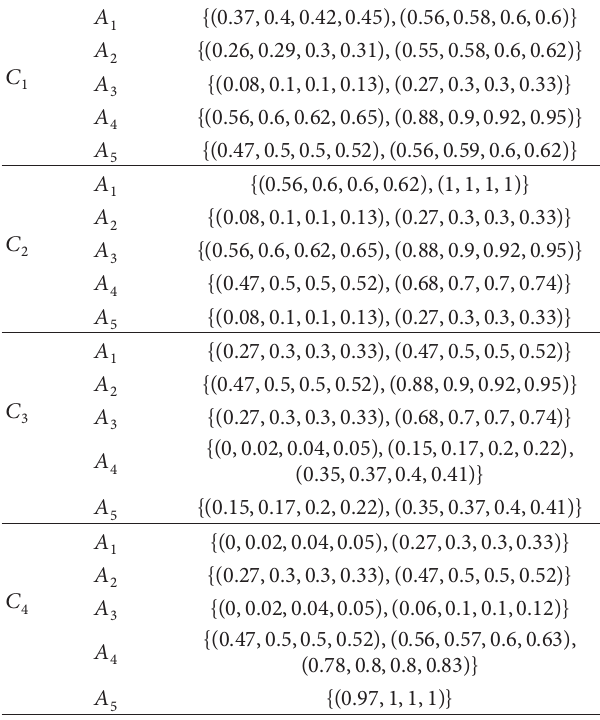
Table 2: Decision matrix ( and 6 ( 𝑒 4 ,𝑒 5 , and 𝑒 6 ).